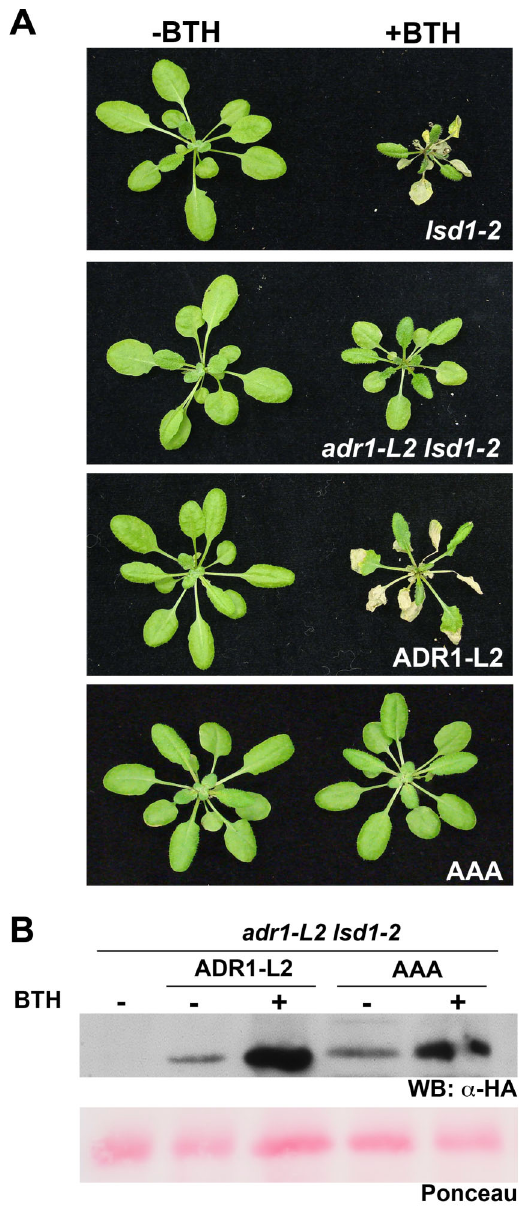
Figure 3. The requirement for ADR1-L2 in lsd1 rcd is P-loop dependent. (A) Four-week-old plants of the indicated genotypes were sprayed with BTH or water. ADR1-L2 and AAA indicate adr1-L2 lsd1 plants expressing C-terminally HA-tagged wild-type ADR1-L2 or the mutated P-loop allele ADR1-L2 AAA , respectively. In both transgenics expression is driven by the native ADR1-L2 promoter. Pictures of plants were taken 5 dpi. (B) Protein from the indicated genotypes was extracted before or after BTH treatment, run on a denaturing gel, and probed with anti-HA antibody. Ponceau-stained blot shows relative